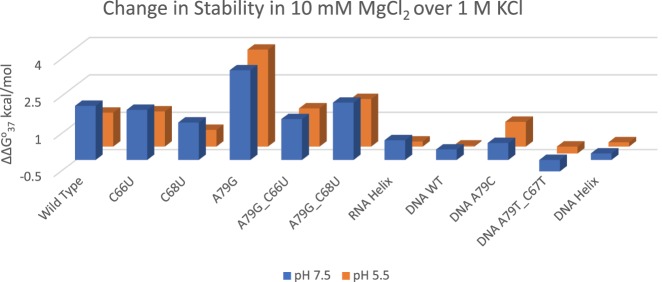
Effects of 10 mM magnesium chloride on construct stability. The ΔΔG° values (in kcal/mol) are shown for two different pH conditions and are calculated as a difference between ΔG°37 in 1 M KCl and 10 mM MgCl2. Positive values indicate a gain in stability in 10 mM MgCl2 over 1 M KCl buffers.